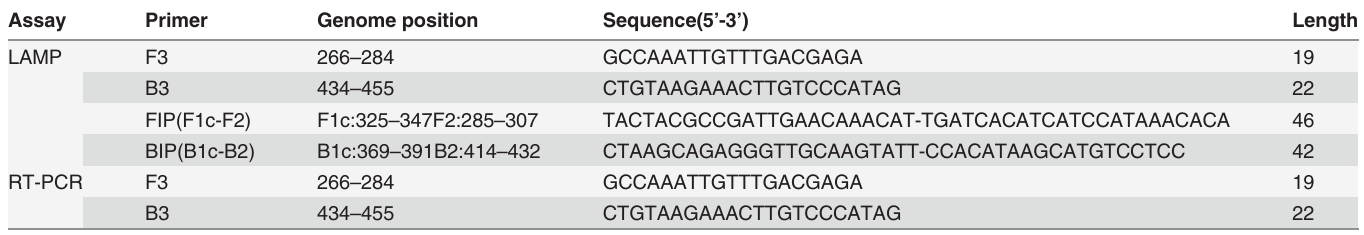
Table 2. The primers for STY2879-LAMP and RT-PCR in this study. Assay Primer